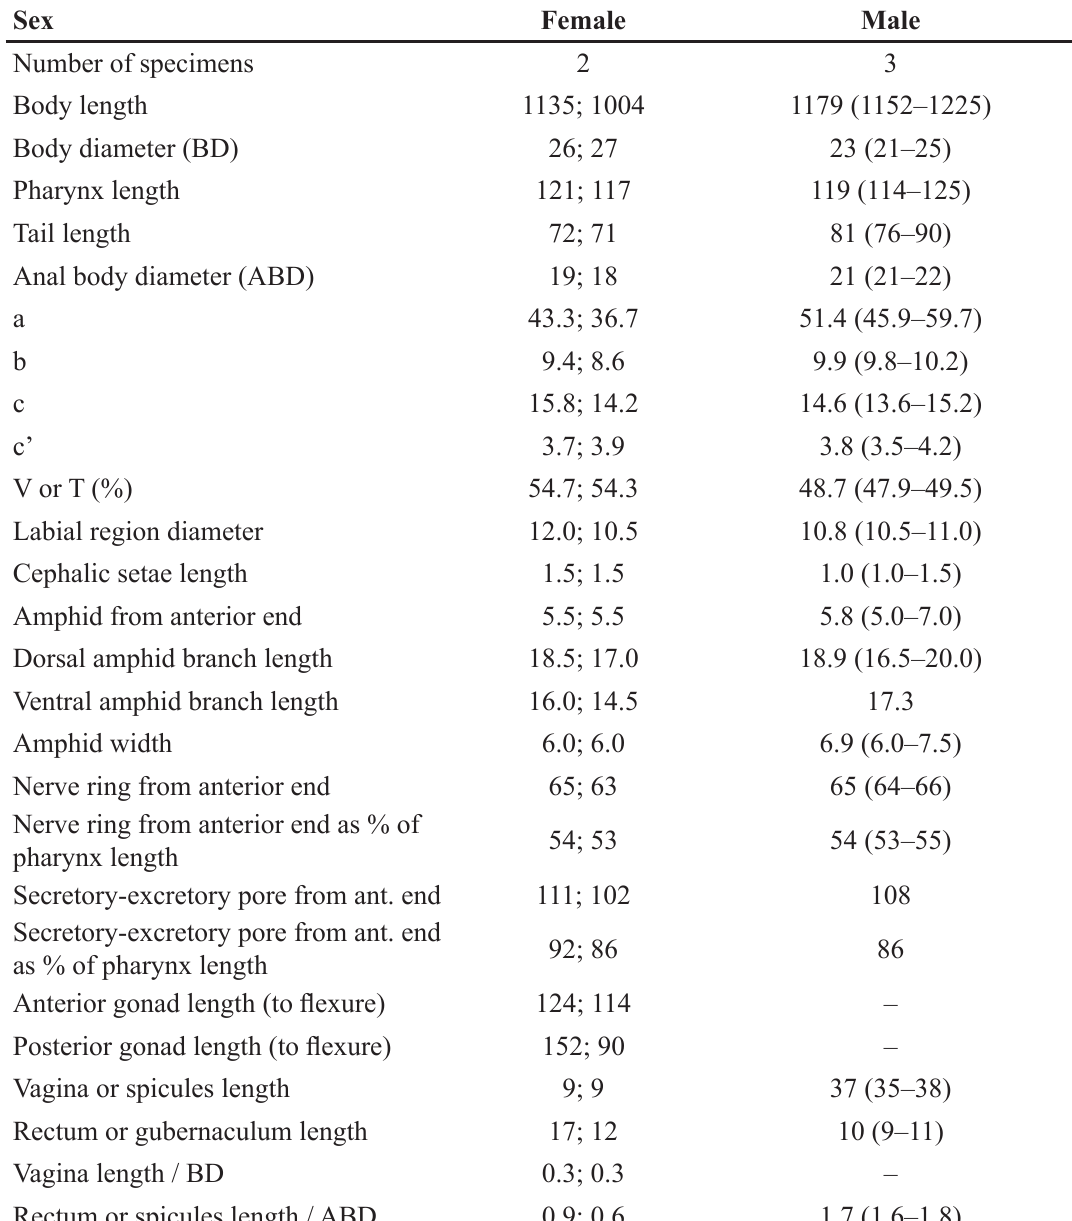
Table 4. Measurements (in µm) of Diplopeltoides nudus (Gerlach, 1956), presented as mean and (range) for males and each female individual measurement separated with a